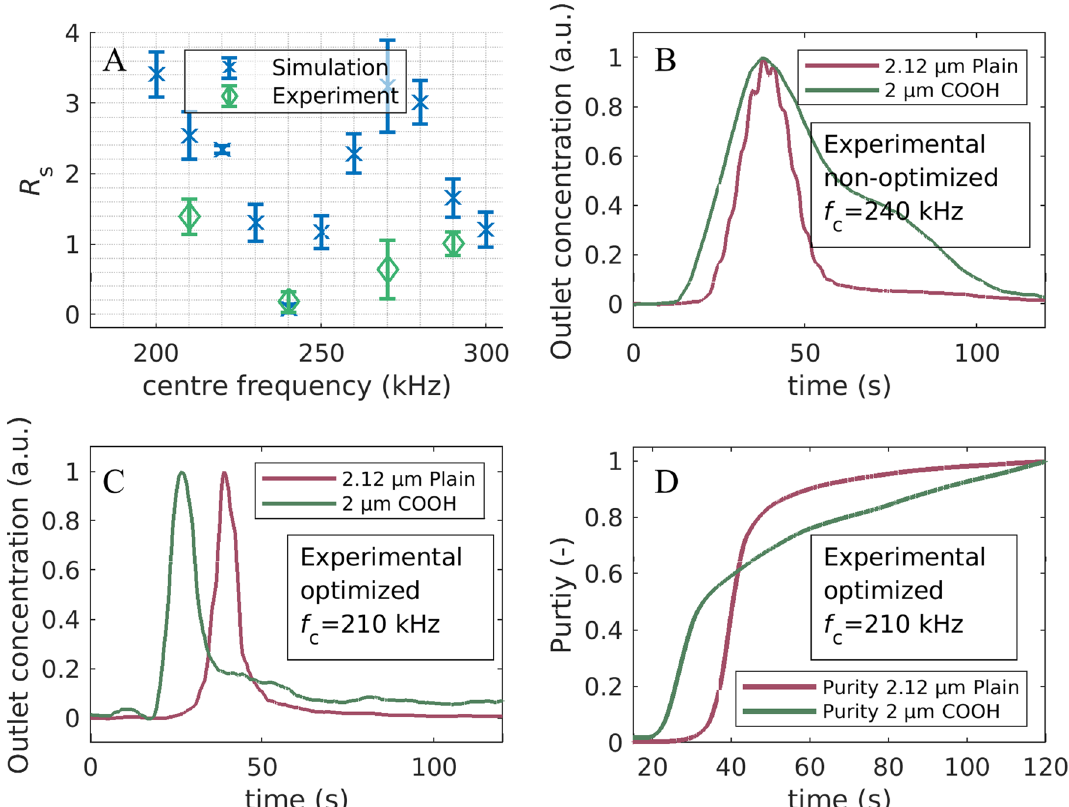
Figure 4. ( A ): Simulated (blue) and experimentally determined (green) resolution R s at different center frequencies ( f c ). Simulations were repeated 5 times. ( B ): Chromatogram of a non-optimized separation of 2 µ m carboxy functionalized and 2.12 µ m plain PS particles at a f c = 240 kHz . ( C ) Chromatogram of an optimized separation of 2 µ m carboxy functionalized and 2.12 µ m plain PS particles at f c = 210 kHz . ( D ) Purity as a function of time at f c = 210 kHz